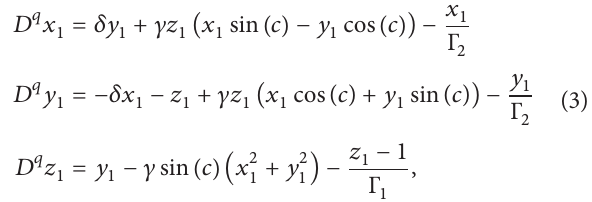
Γ = 0.5 , Γ = 0.25 , and the orders 𝑞 1 2 0.98 , the bifurcation and the corresponding LLE diagrams of system (2) varying the parameter 𝛿 are depicted in Figure